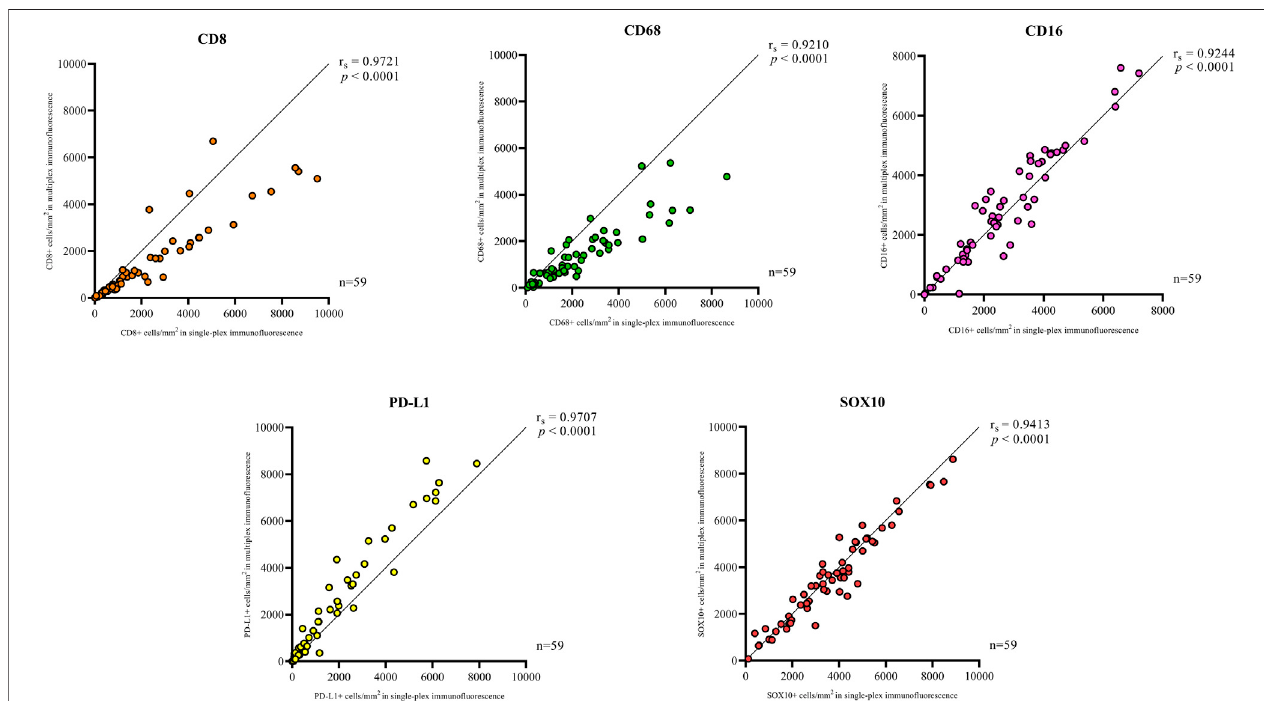
FIGURE 7 | Correlation plots compare the correlation between the cell densities for each marker in single-plex immuno fl uorescence and multiplex immunohistochemistry. An average of the cell densities of each marker across the three multiplex immuno fl uorescence sections was used to compare with the single- plex immuno fl uorescence marker celldensity. Signi fi cantpositivecorrelationsbetween thesingle-plex immuno fl uorescencecell densities and theaveragecelldensity of the multiplex immuno fl uorescence wereobserved forall markers. CD8 displayed the strongest correlation between single-plex immuno fl uorescence and multiplex immuno fl uorescence. Data are Spearman ’ s correlation values with p <